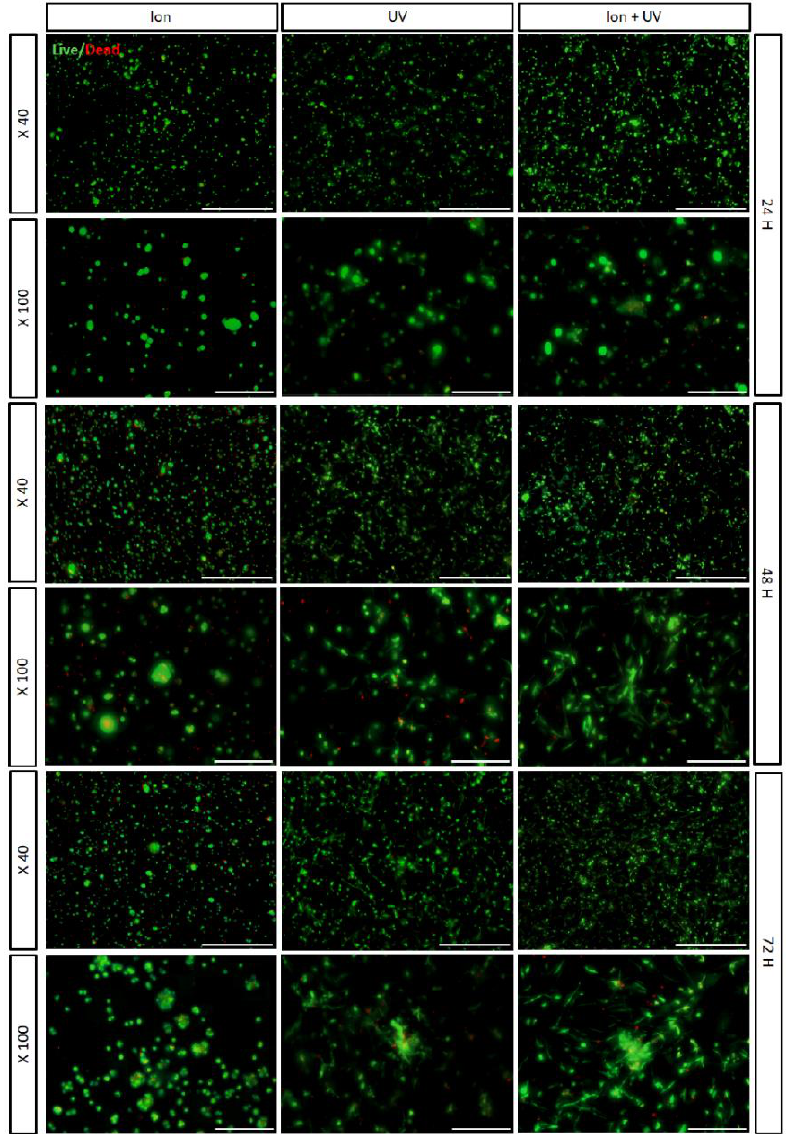
Figure 4. Fluorescence micrograph of Live/Dead assay. Large number of encapsulated hMSCs aggregates can be observed for ion conditions at 24, 48, and 72 h (scale bar = 40×, 500 μm; 100×, 200 μm).